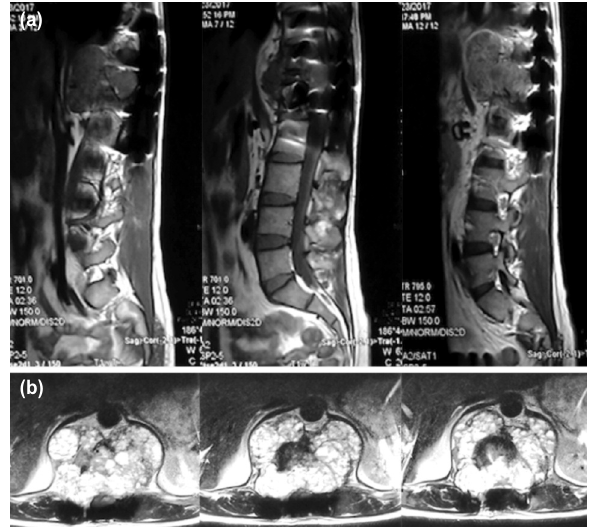
(a) Pre-operative MRI sagittal view (T1 Weighted - from Fig. 1: left to right) showing the mass extending anteriorly involving T11,T12 and L1. (b) Pre-operative MRI axial view (T2 Weighted) at the level of T12 showing an expansile mass surrounding the T12 vertebrae.